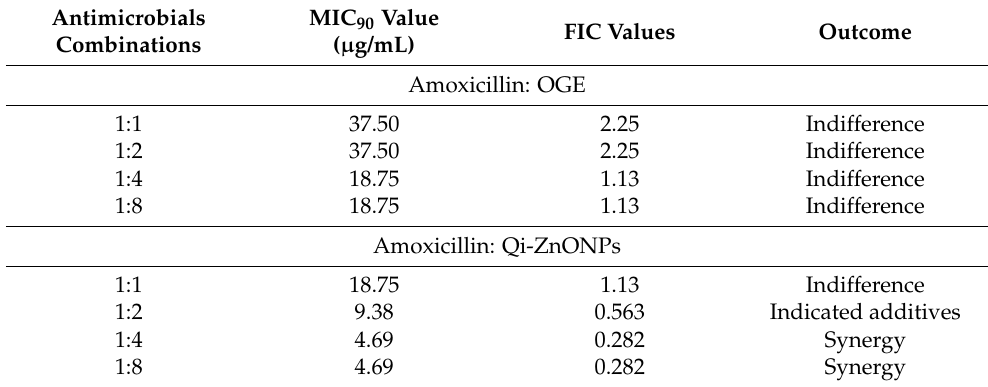
Table 4. Fractional inhibitory concentrations (FIC) of different combinations of the OGE/Qi-ZnONPs and antibiotics against H. pylori (ATCC-43526) using the checkerboard micro-dilutions